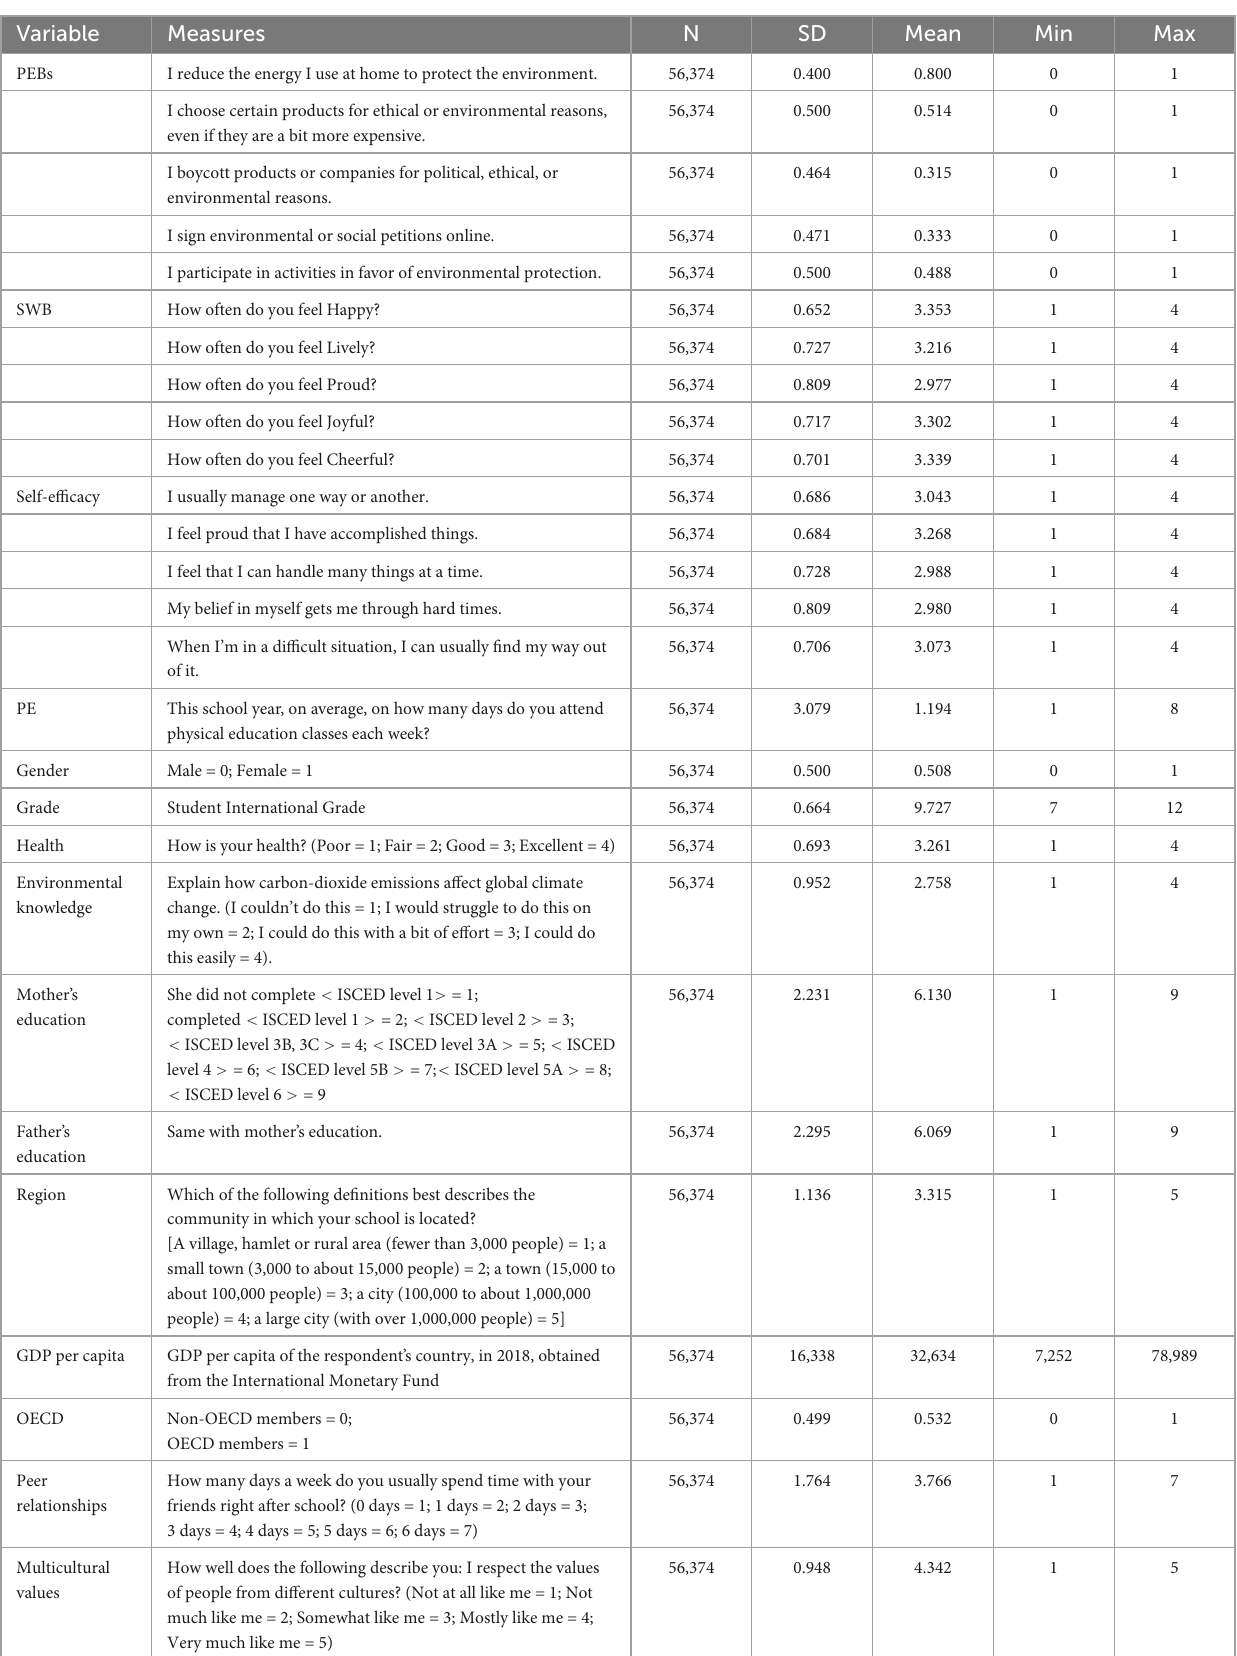
TABLE 4 Descriptive